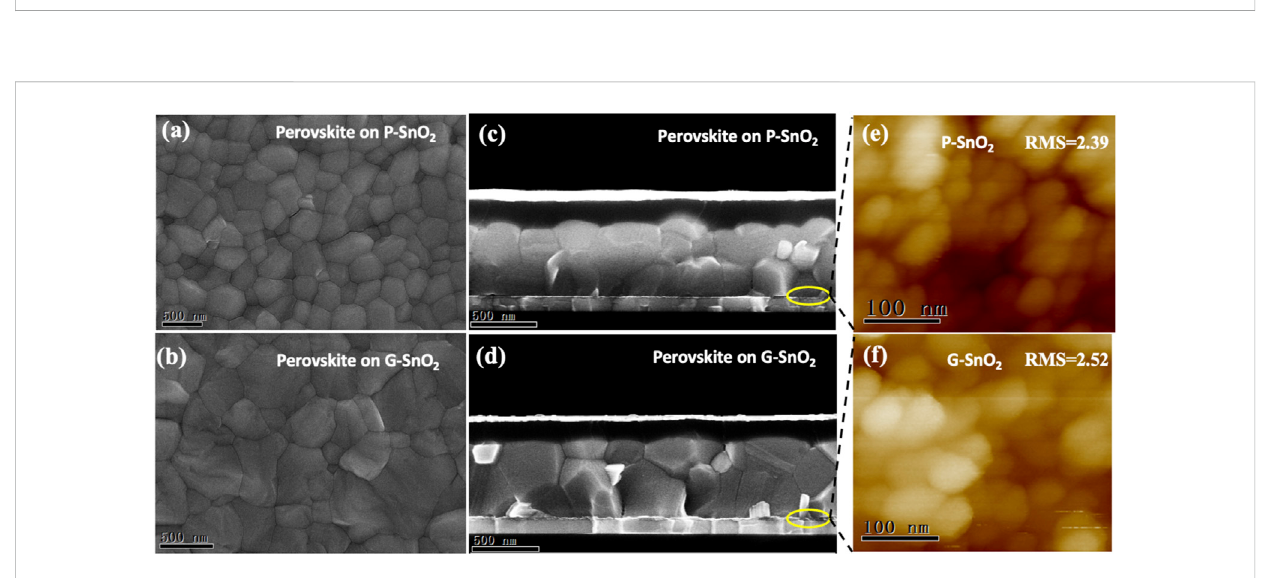
FIGURE 3 (A – D) SEMtopandcross-sectionviewoftheperovskitelayergrownonP-andG-SnO 2 ,respectively (E,F) AFMimagesofthetinoxidesurfacew/wo Gua-Cl doping (scale bar: 100